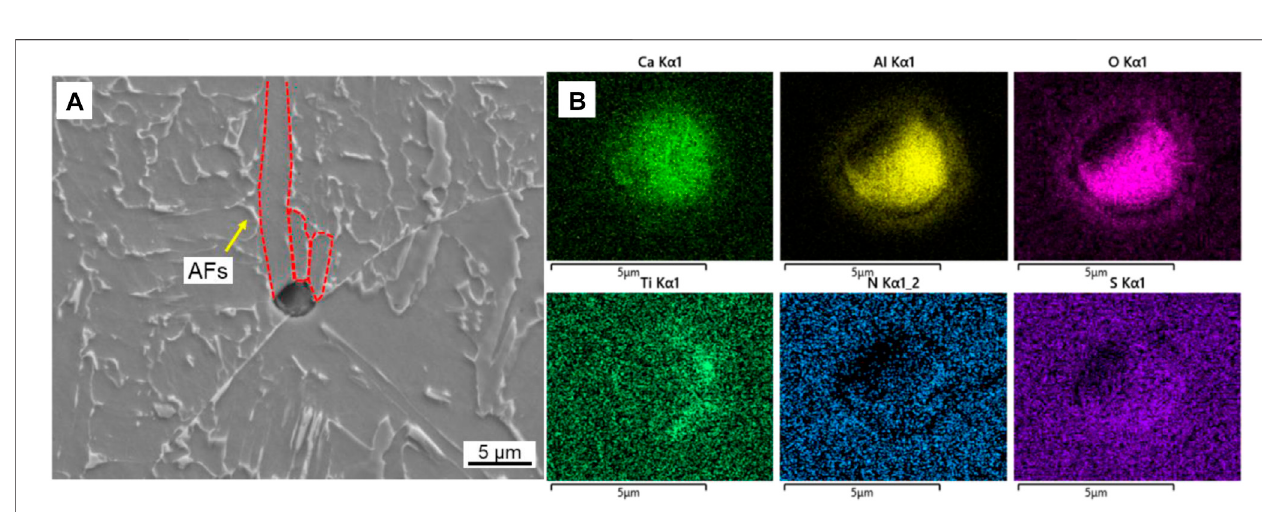
FIGURE 4 | (A) Typical morphology of AF and inclusion and (B) the corresponding EDS mapping result in the CGHAZ at the heat input of 150 kJ/cm.